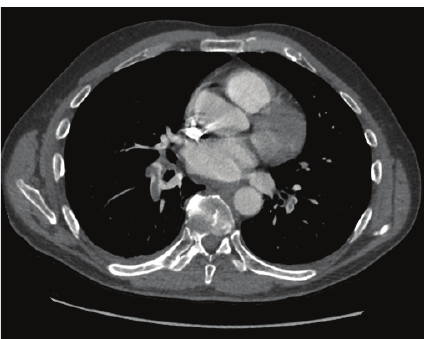
Figure 1: Chest CT showing bilateral filling defects involving the right and left main pulmonary arteries with extension to the segm- ental branches of the right middle and bilateral lower